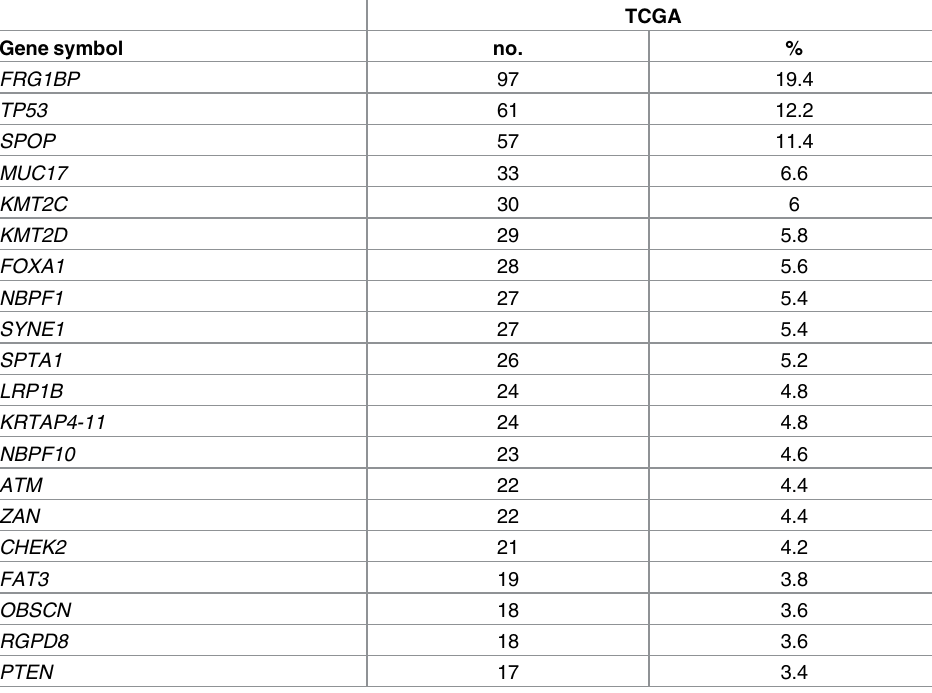
Table 4. Top 20 mutations identified within PRAD